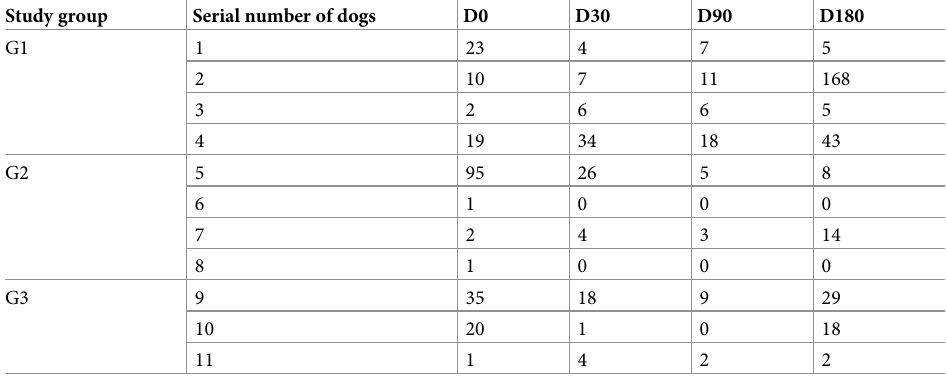
Table 1. Number of skin-dwelling microfilariae detected from dogs in the control and treatment groups. Study